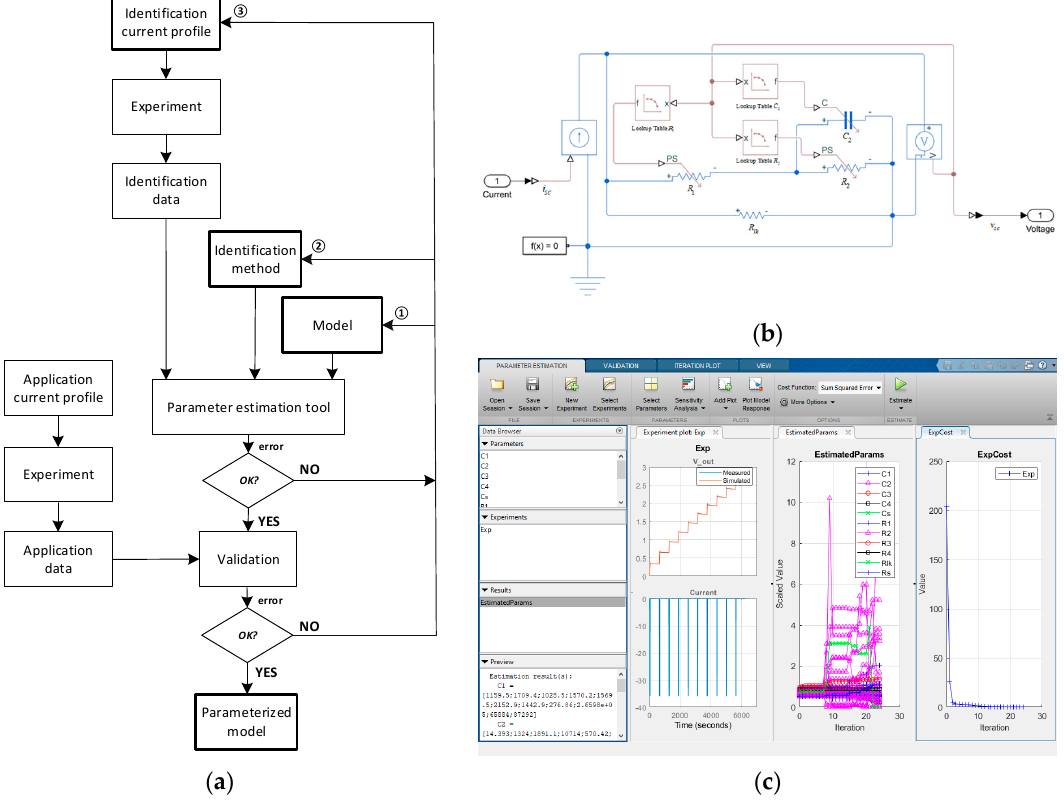
Figure 7. Parameter estimation procedure: ( a ) Identification block diagram process; ( b ) Simscape model; ( c ) Interactive interface by Simulink [45].